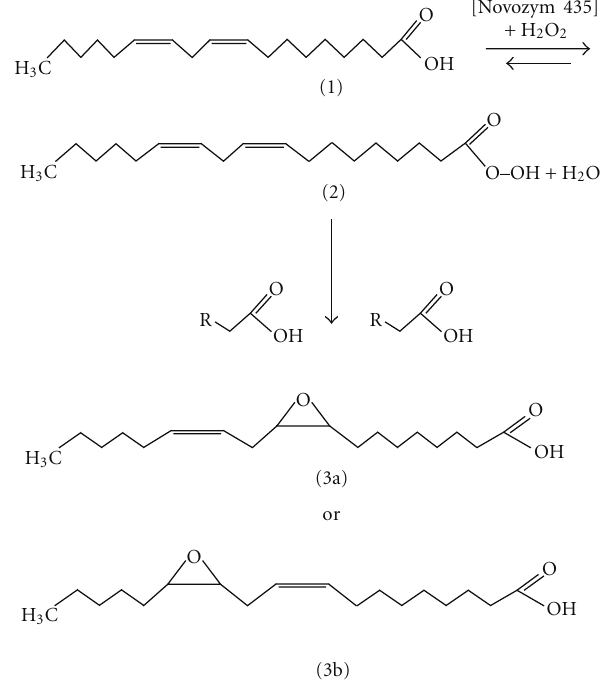
Figure 1: Chemoenzymatic MEOA. Notes: linoleic acid (2); perli- noleic acid (3); 9-10-monoepoxy 12-octadecenoic acid (3a); 12-13- monoepoxy 9-octadecenoic acid (3b).